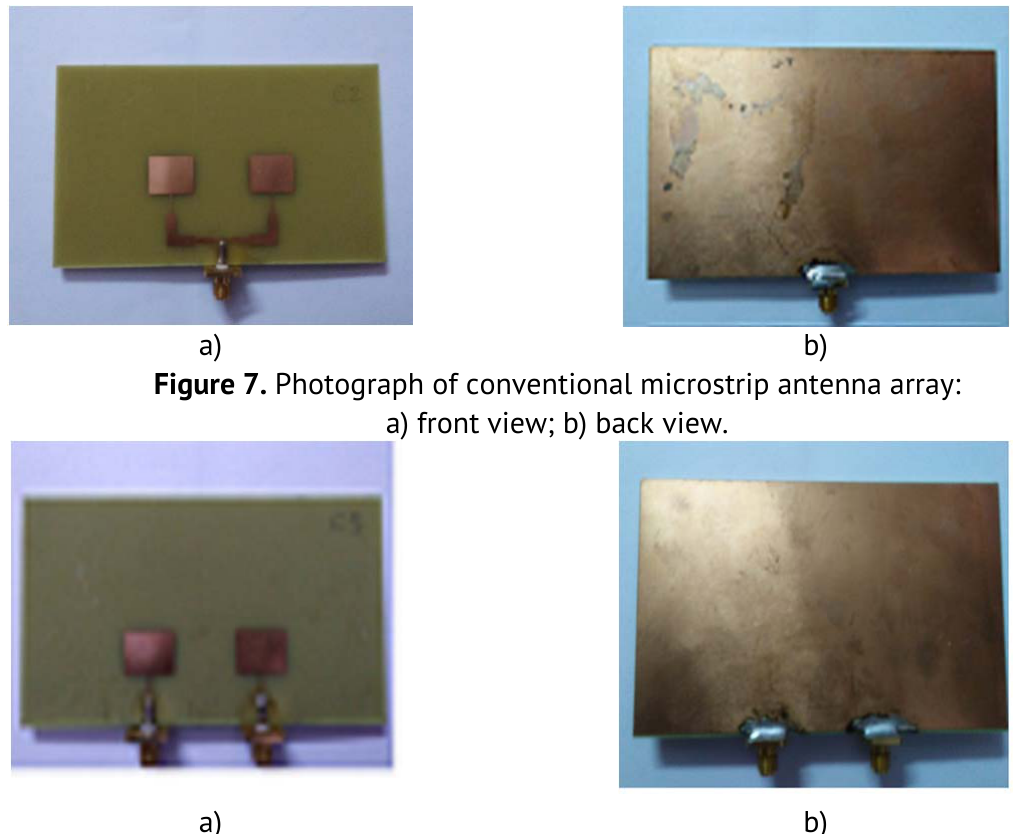
Figure 8. Photograph of setup of conventional microstrip antenna array for mutual coupling measurement: a) front view; b) back